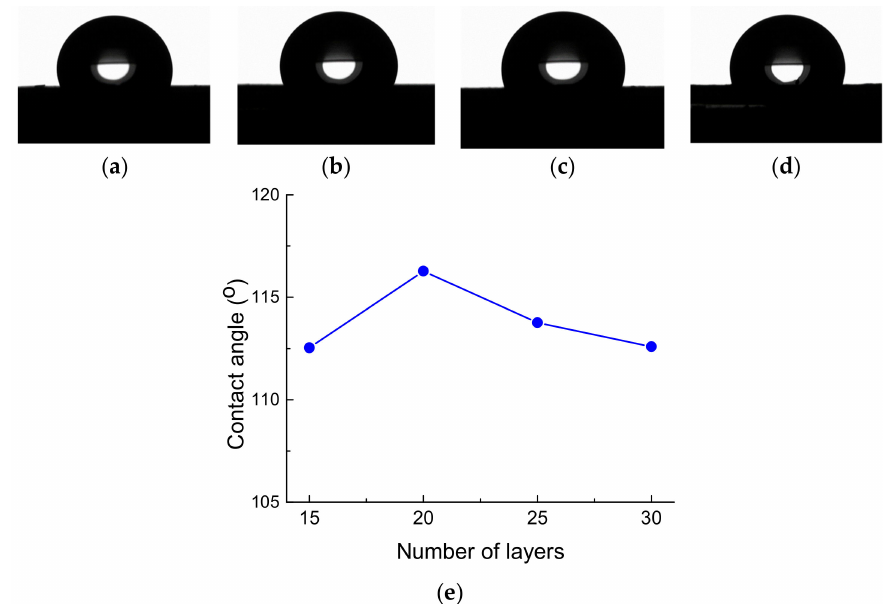
Figure 9. Variation of contact angle of CHA coatings with increasing number of layers ( e ) and the images of water drops on CHA surfaces coated with ( a ) 15, ( b ) 20, ( c ) 25, and ( d ) 30 sol-gel layers. All CHA samples were immersed into simulated body fluid (SBF) for one month. The phases and morphology were examined after 2, 3, and 4 weeks. The XRD patterns of the CHA samples